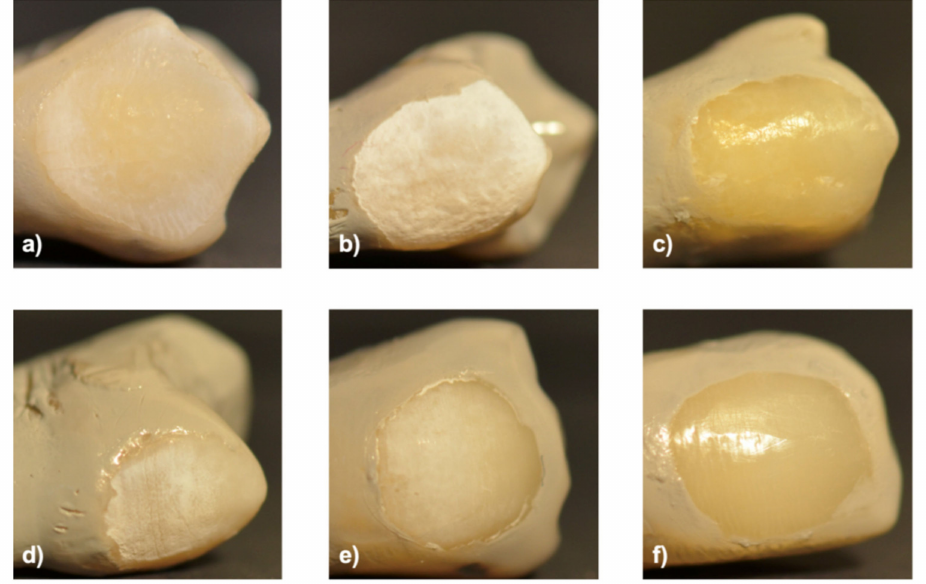
Figure 3. The enamel after being placed for 1 h in: ( a ) hydrochloric acid; ( b ) orthophosphoric acid; ( c ) lactic acid; ( d ) orthophosphoric acid solution; ( e ) formic acid; ( f ) CaCl 2 , NaH 2 PO 4 and acetic acid